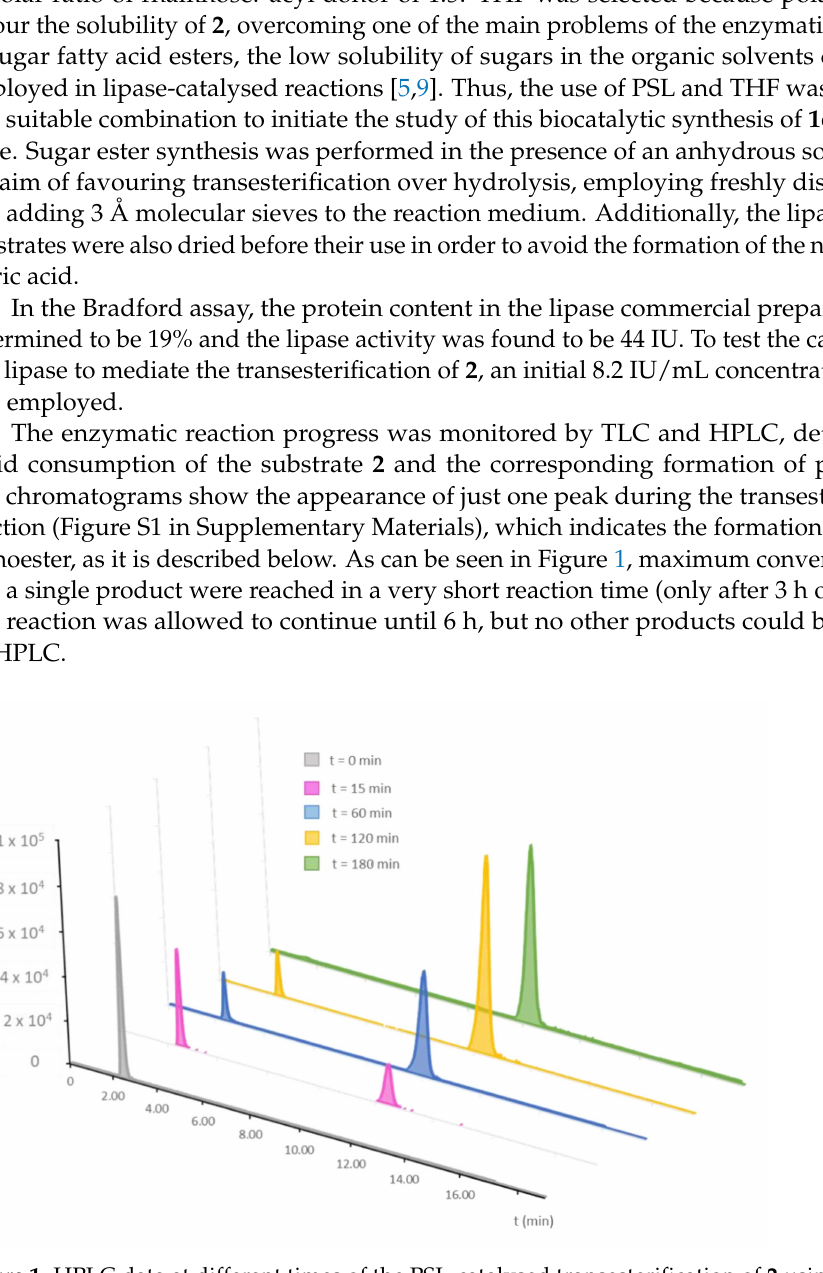
Figure 1. HPLC data at different times of the PSL-catalysed transesterification of 2 using 3e as acyl donor in THF at 35 ◦